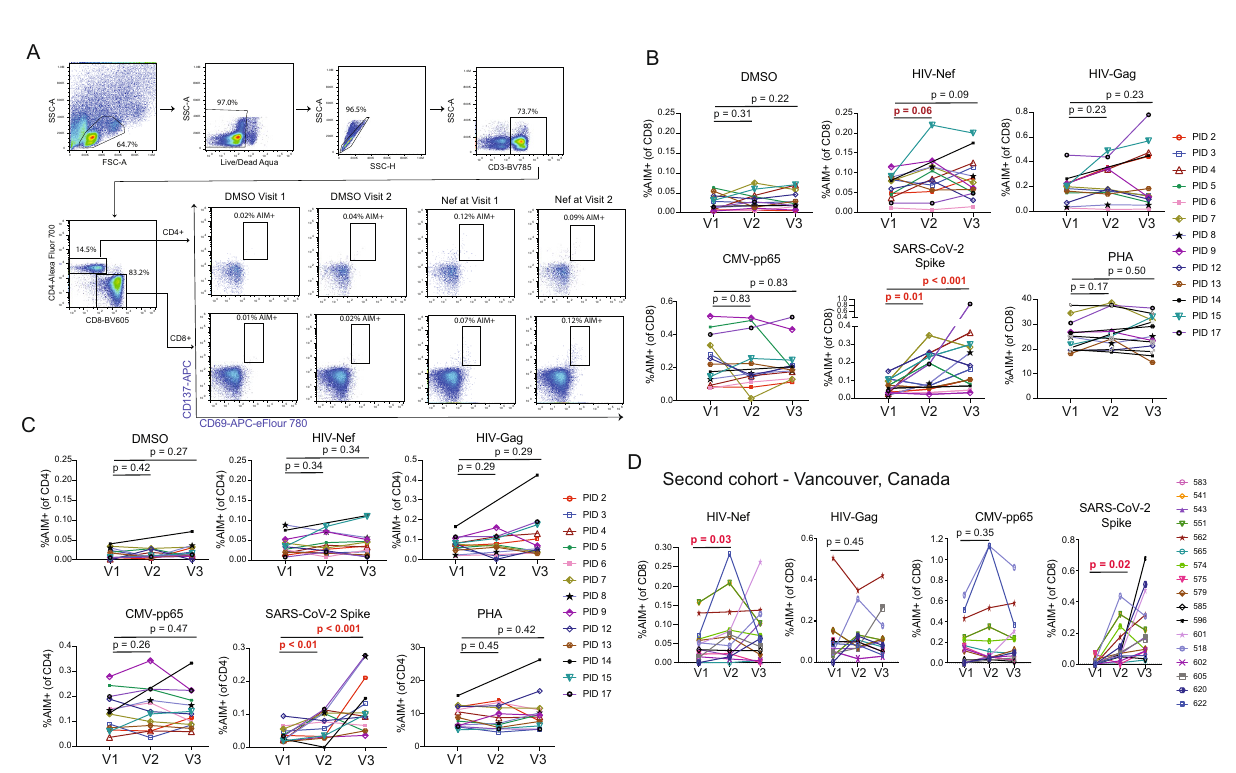
Fig. 3 | Sustained increases in SARS-CoV-2-speci fi c CD4 + and CD8 + T-cell responses and transient increases in HIV Nef-speci fi c CD8 T-cells following COVIDmRNAvaccination.A RepresentativegatingschematicforTCR-dependent activation induced marker (AIM)+populations (CD69+ CD137+) after stimulation withHIV,SARS-CoV-2orCMVgeneproducts. B , C CombinedAIM+CD8 + andCD4 + T-cells results for n =13 ARV-treated donors at baseline (V1), and ∼ 2 weeks after vaccinedose1(V2)orvaccinedose2(V3).CD8+- B ,CD4+- C Datapointsrepresent means of duplicates. All responses are background (DMSO) subtracted, with the